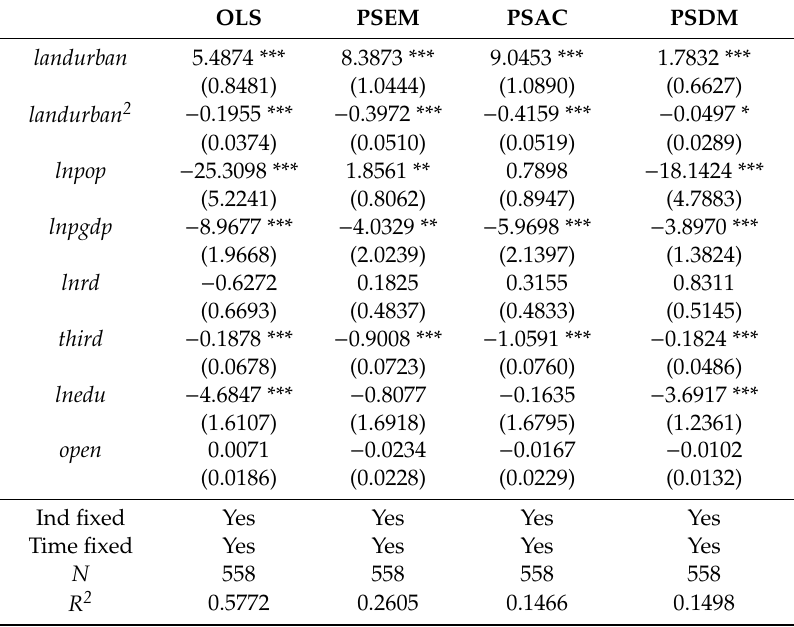
Table A1. Estimated results of di ff erent